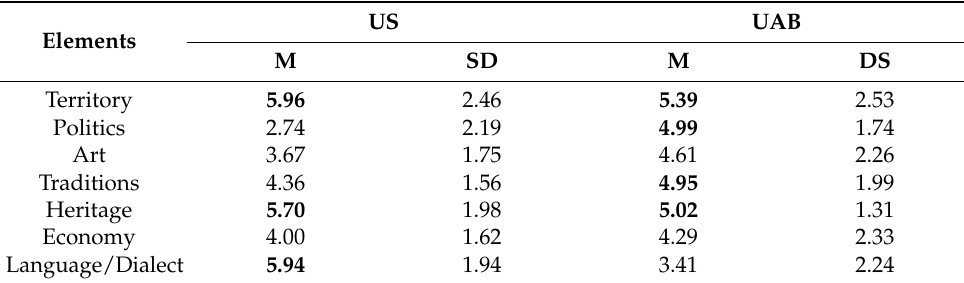
Table 7. Descriptive elements for working on identities in the classroom.